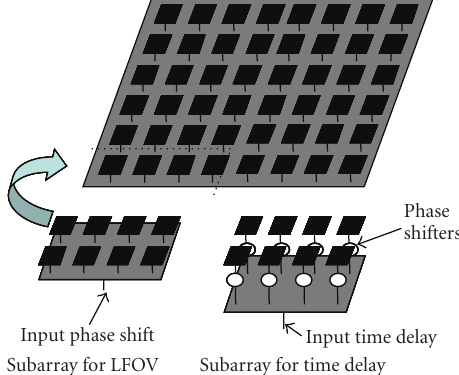
Figure 1: Subarray applications to LFOV and time-delayed wide- band